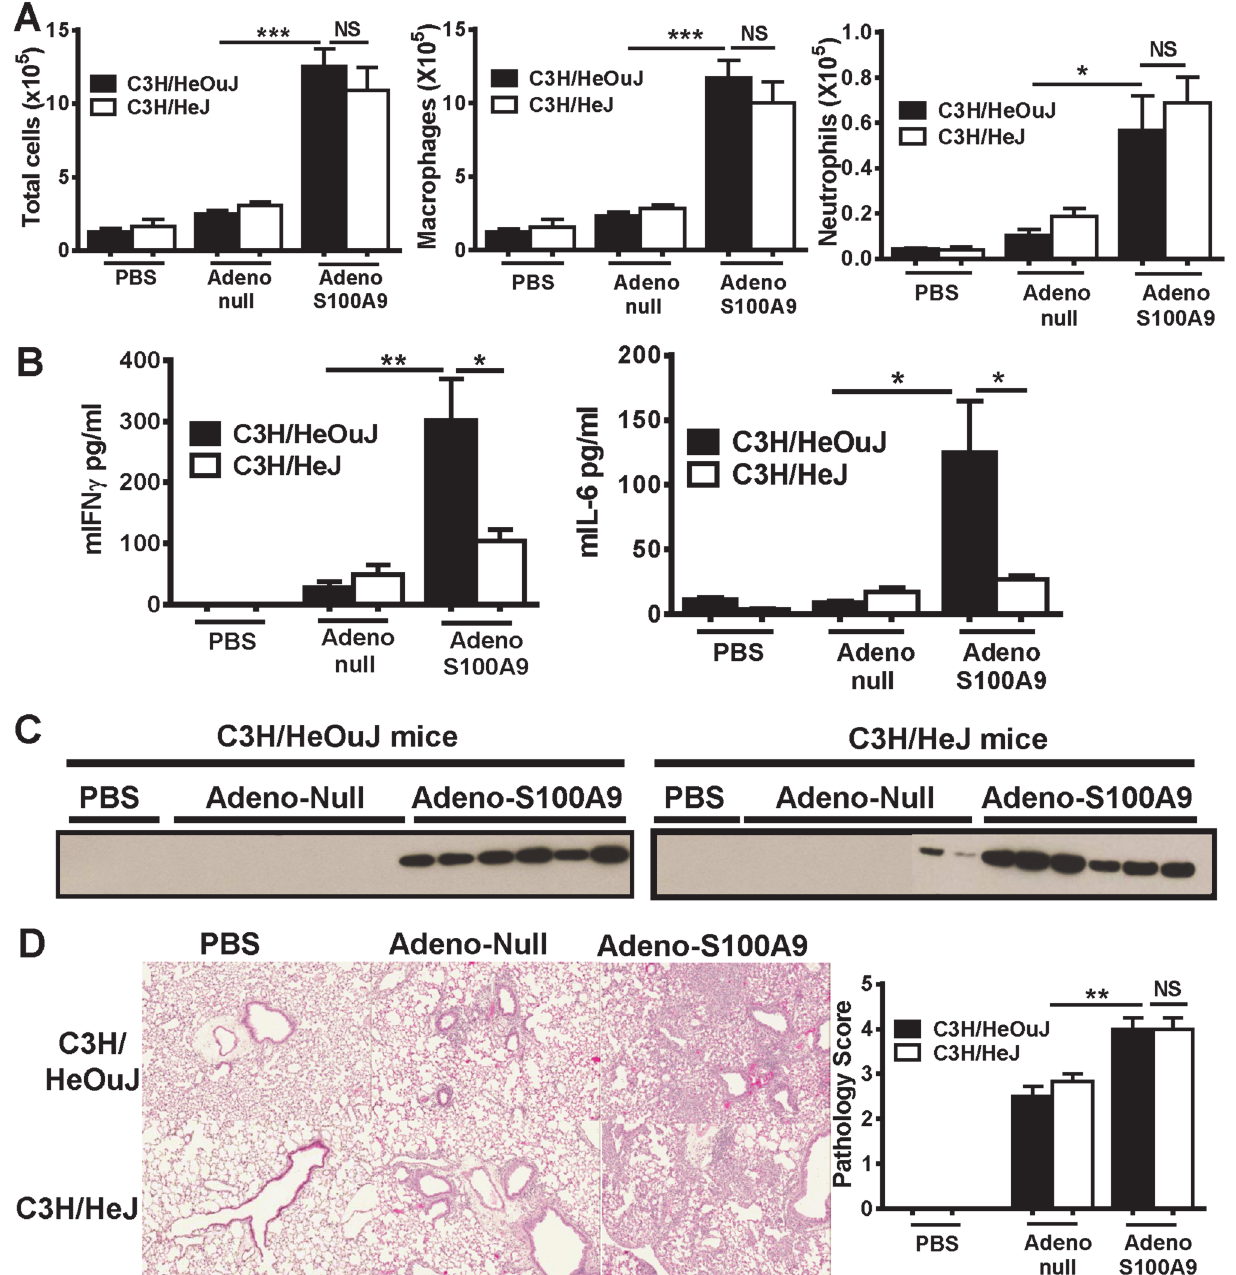
Fig 7. Murine S100A9 induced inflammatory infiltrates are TLR4-independent. Adeno-murine S100A9, Adeno-null or PBS was administered intranasally into wild-type (C3H/HeOuj) and TLR4-defective (C3H/HeJ) mice. After 10 days, mice were euthanized and BAL fluids or lung tissue was collected for analysis. (A) Cells were obtained from the BAL fluids using cytospins, stained with diff-quik and the total cell counts, neutrophil counts and macrophage counts were recorded. (B) mIFN γ and mIL-6 expression in BAL fluid in wild type and TLR4 defective mice. (C) Western blot analyses of mS100A9 expression in BAL fluid in wild type and TLR4 defective mice. (D) H&E staining of paraffin fixed lung tissue (left panel), and pathology scores (right panel). Non-parametric Mann-Whitney test was used to determine statistical difference between two groups.